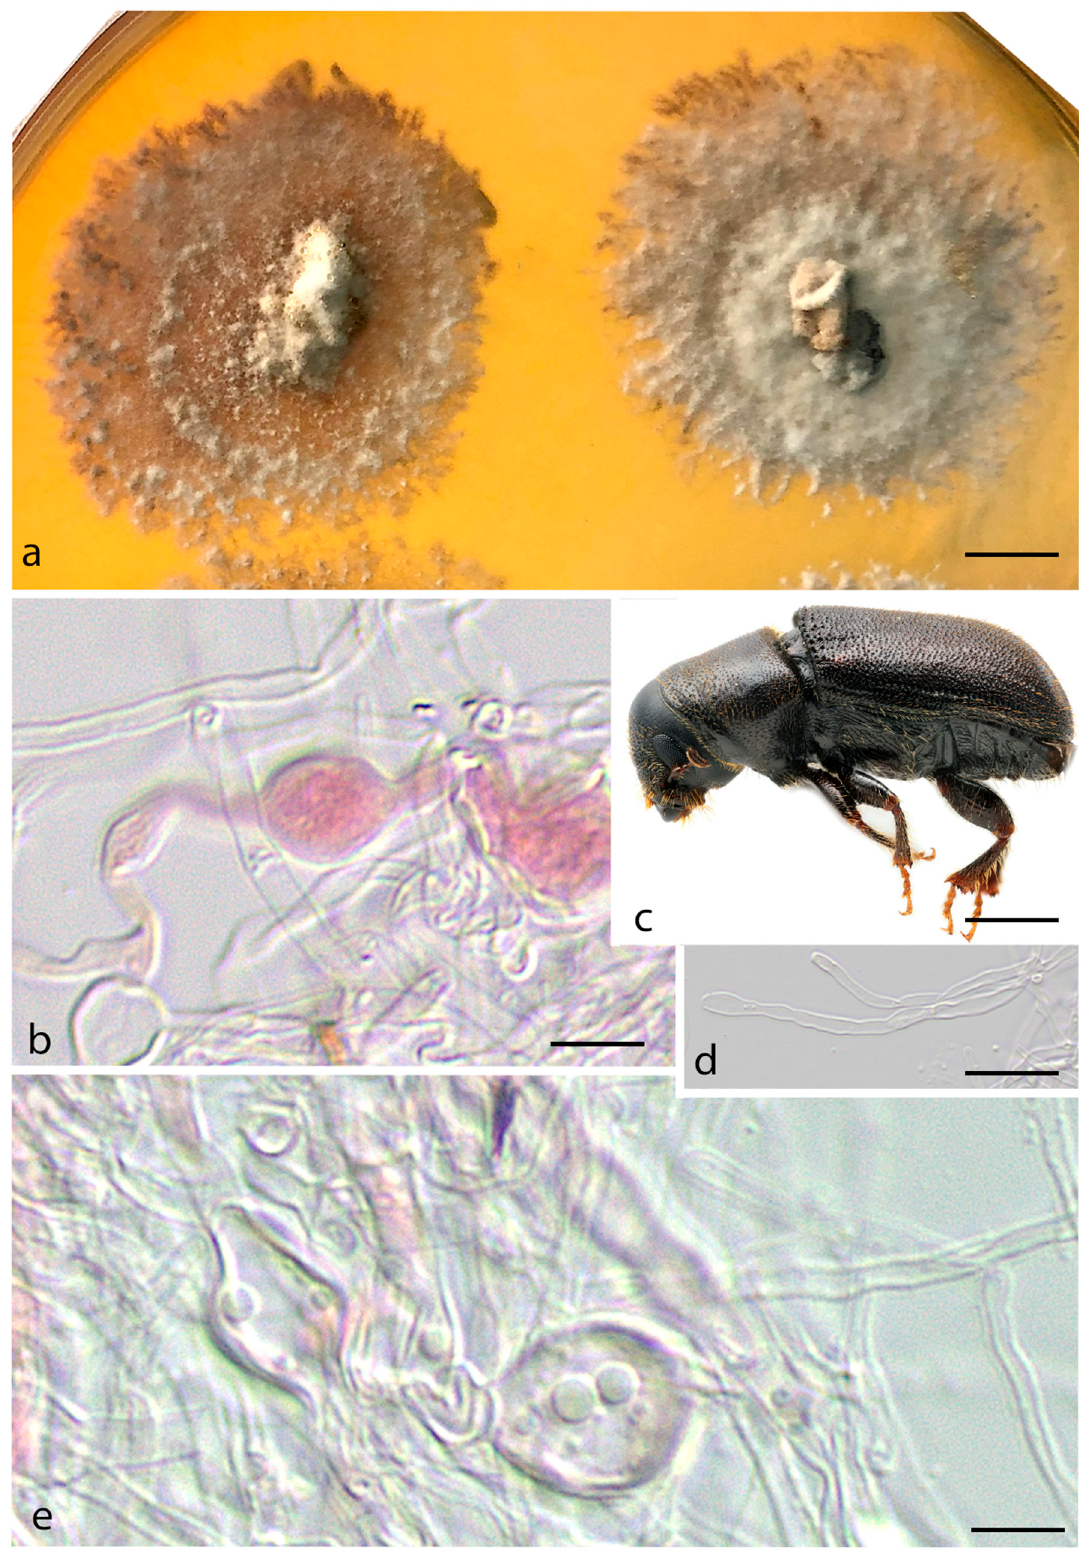
Figure 4. Entomocorticium perryae. ( a ) Culture aspect on PDA plate; ( b ) Chlamydospore in formation; ( c ) Dendroctonus brevicomis (vector); ( d ) Apical hyphae; ( e ) Chlamydospore. Scale bars: ( a ) = 1 cm; ( b ) = 5 µm; ( c ) = 2 mm; ( d , e ) = 5 µm. Entomocorticium belizense Araújo, Li & Hulcr, sp. nov.–MycoBank MB 839835; Fig- ure 5.